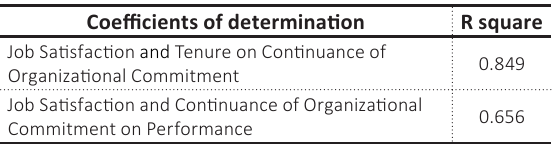
Table 4. Coefficients of determination